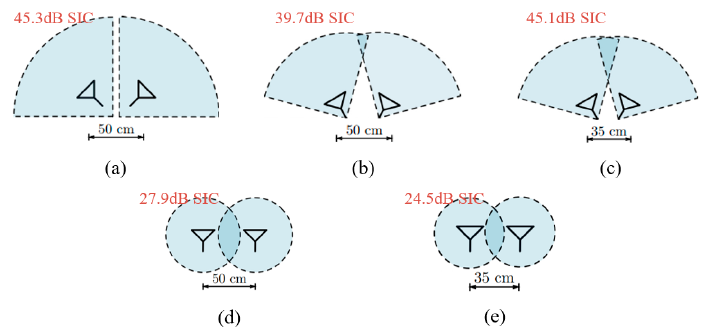
Figure 5. Five configurations of antenna separation with their SIC performance investigated in [11]. ( a ) 90° directional separation with 50 cm spatial separation. ( b ) 60° beam separation with 50 cm antenna separation. ( c ) 60° beam separation with 35 cm antenna separation. ( d ) 50 cm antenna separation. ( e ) 35 cm antenna separation. Note the antennas in ( a ) ‐ ( c ) have 90° beamwidth and the antennas in ( d )–( e ) are omnidirectional.